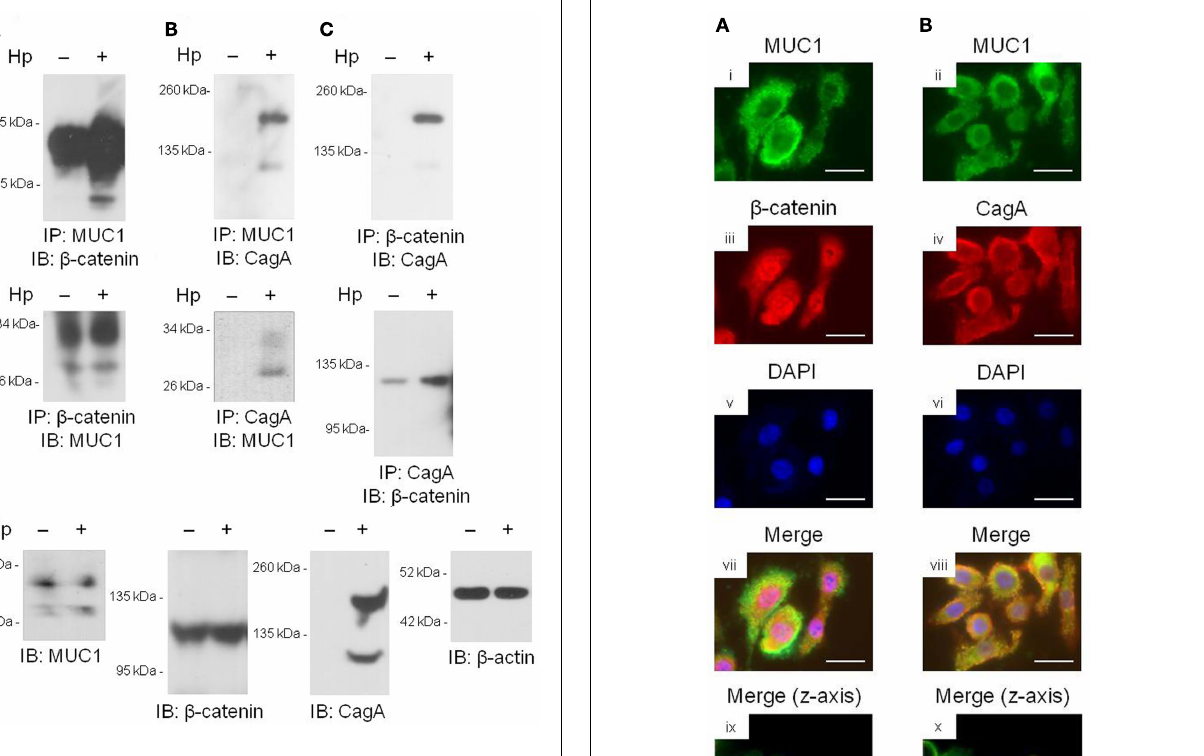
FIGURE 2 | Co-immunoprecipitation of MUC1, β -catenin, and H. pylori CagA. (A–C) AGS cells were untreated or were treated with H. pylori (Hp) at an MOI of 100. At 24h post-infection, the cells were washed and cell lysates were immunoprecipitated with the indicated antibodies. Immunoprecipitated proteins were resolved by SDS-PAGE, transferred to PVDF membranes, and processed for immunoblotting with the indicated antibodies. (D) Lysates of untreated or HP-treated AGS cells were resolved by SDS-PAGE, transferred to PVDF membranes, and processed for immunoblotting with antibodies to MUC1, β -catenin, CagA, or β -actin. Molecular weight markers are indicated on the left in kilodaltons (kDa).The results are representative of two experiments.